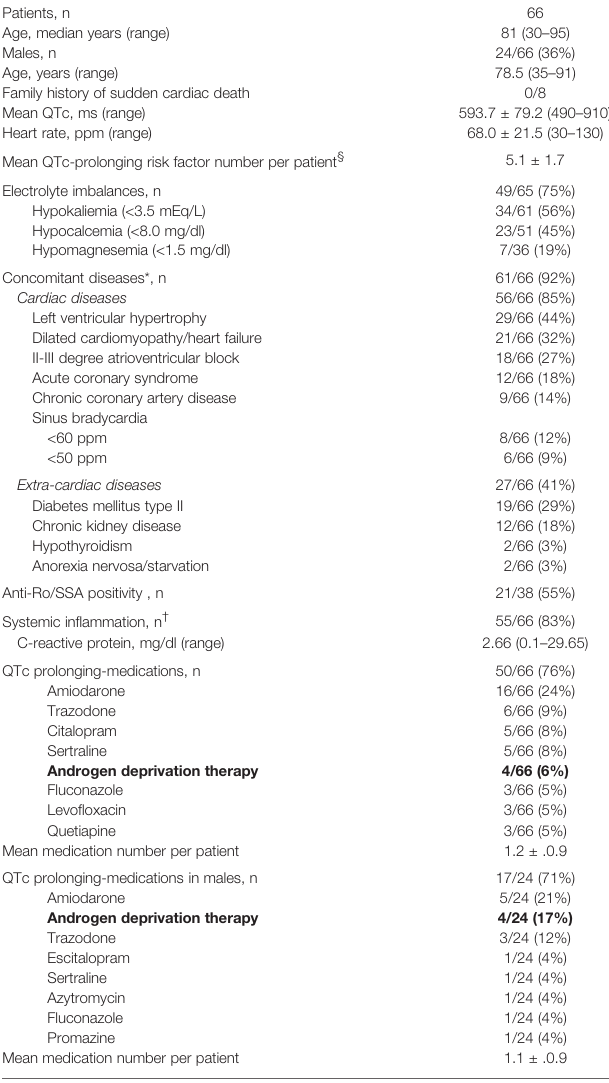
TABLE 1 | Demographic, clinical, and laboratory characteristics of patients with Torsades de Pointes. Patients,